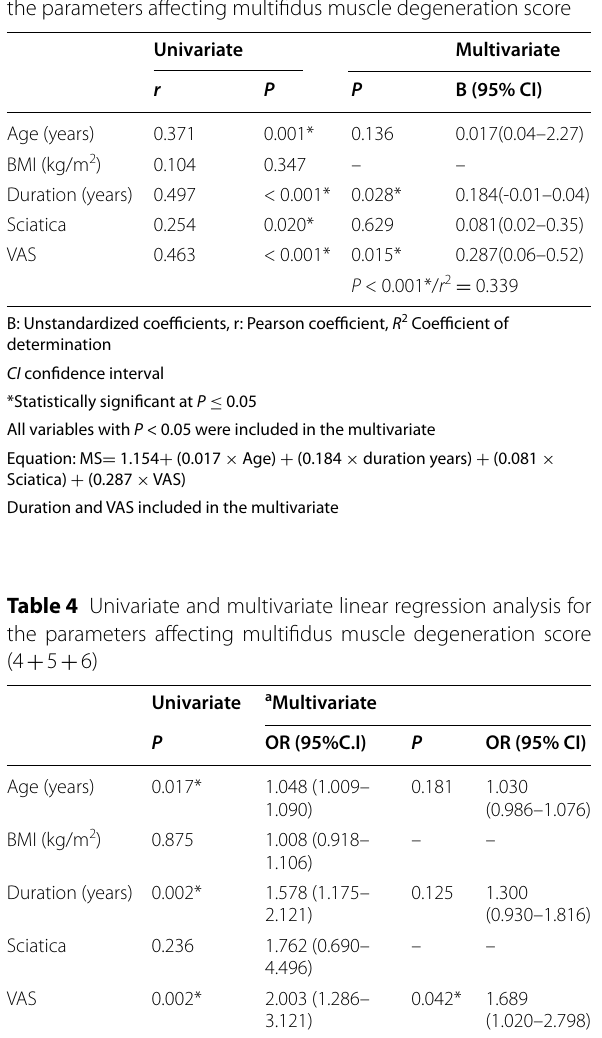
Table 3 Univariate and multivariate linear regression analysis for the parameters affecting multifidus muscle degeneration score